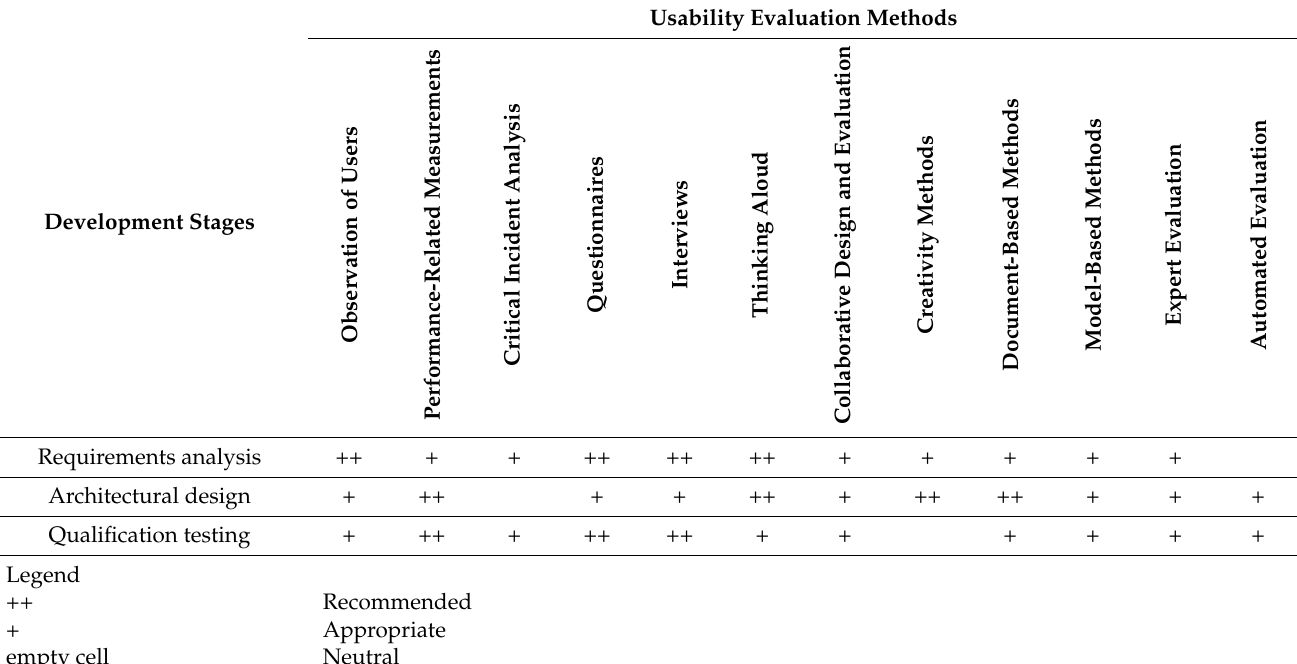
Table 1. Usability evaluation methods recommended based on the development stage.